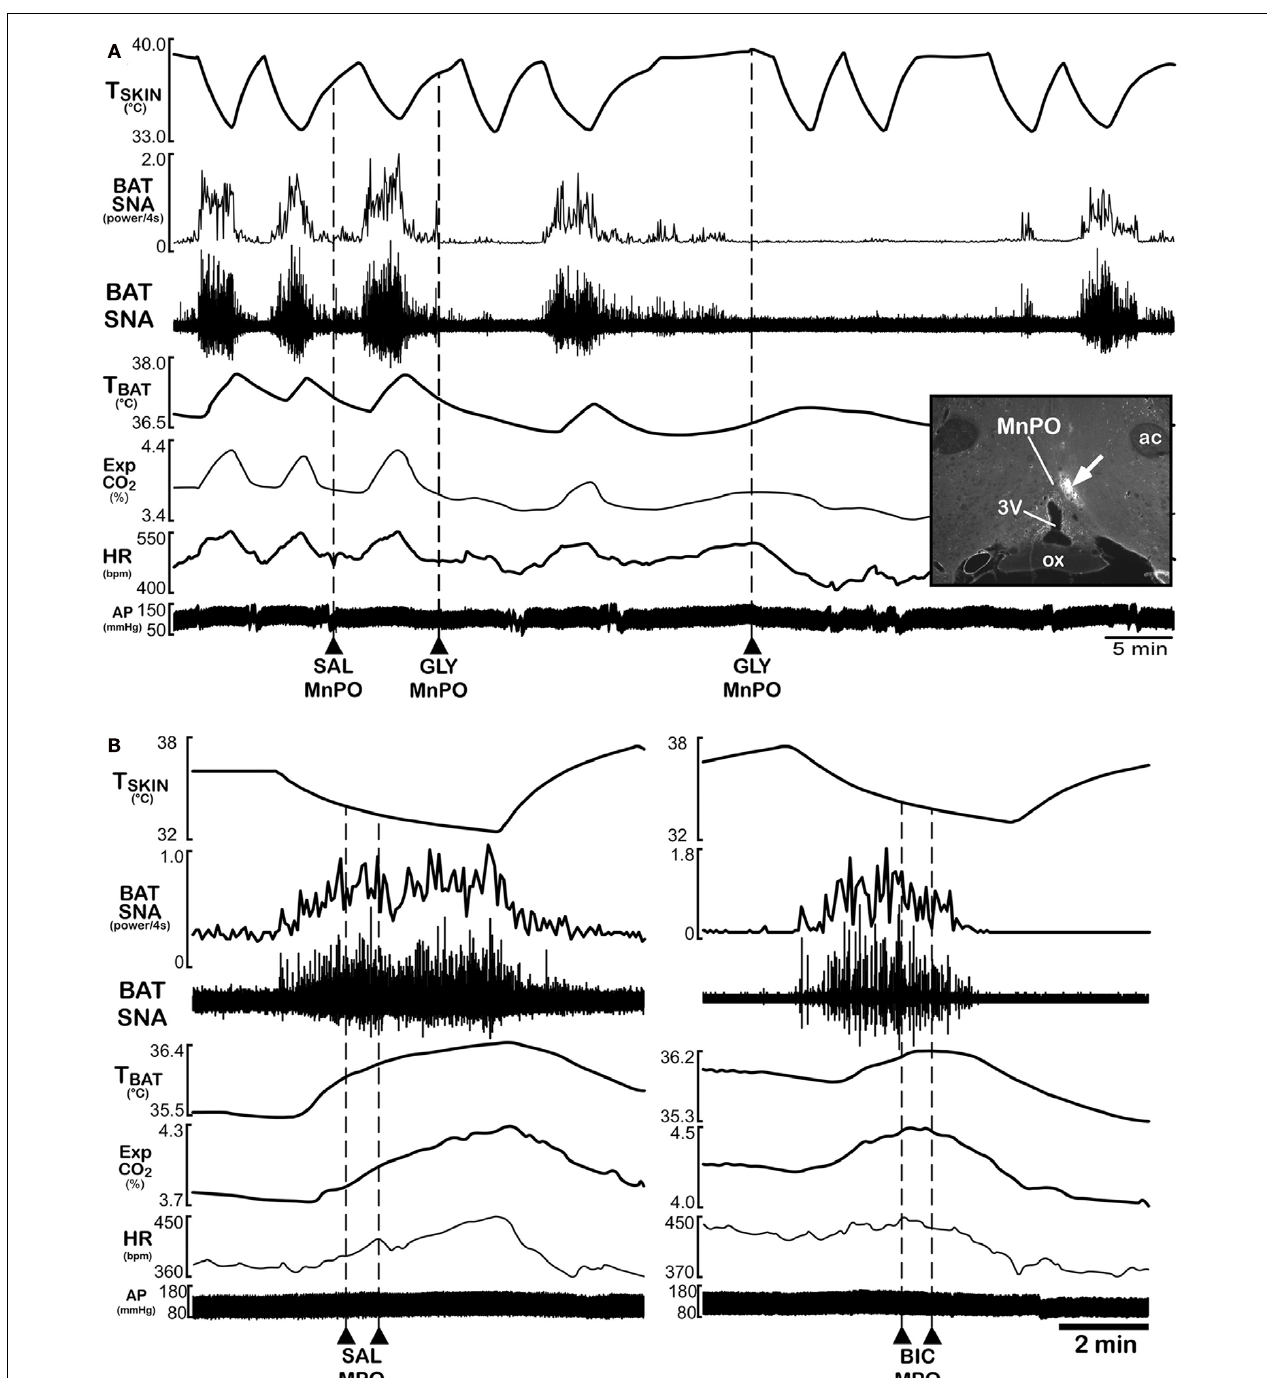
FIGURE 2 | Inhibition of neurons in the median preoptic nucleus (MnPO) or blockade of GABA A receptors in the medial preoptic nucleus (MPO) prevents skin cooling-evoked BAT thermogenesis. (A) Before and after injection of saline (SAL) vehicle into the MnPO [inset: typical injection site (arrow) in the MnPO; 3v, third ventricle; ox, optic chiasm; ac, anterior commissure], episodes of skin cooling evoke increases in BAT sympathetic nerve activity (SNA), BAT temperature (TBAT), expired CO 2 (Exp CO 2 ), and heart rate (HR), with no change in arterial pressure (AP). Following